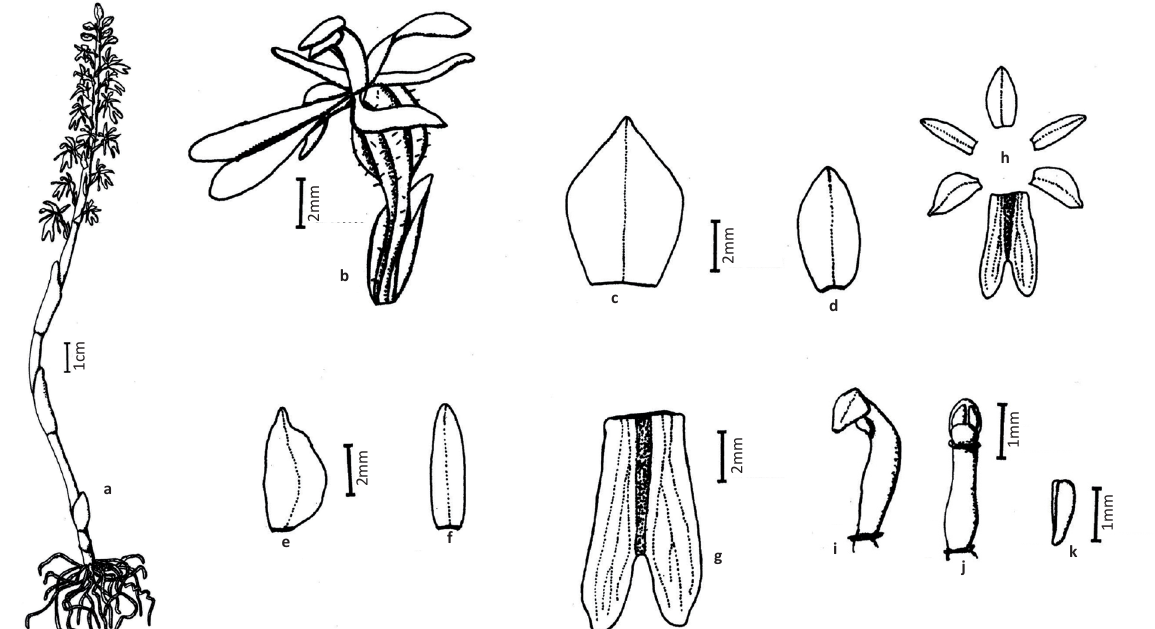
Figure 1 a–k. Neottia listeroides Lindl. a - A plant showing habit (note the highly clustered roots); b - flower; c - floral bract; d - dorsal sepal; e - lateral sepal; f - petal; g - lip; h - floral parts spread (not to scale); i–j - column; k -